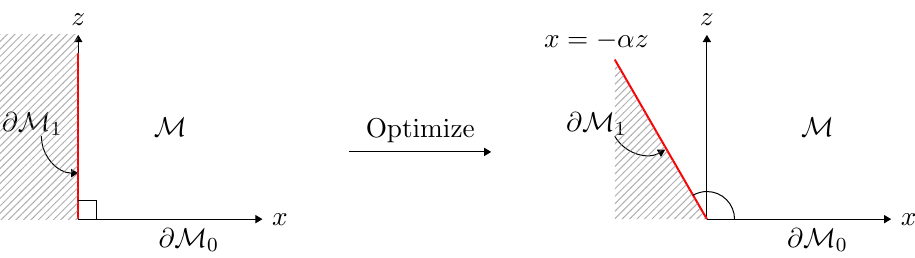
Figure 1 . (Left) The setup of the path integral for vacuum wave functional in BCFT. The boundary @ M 1 is located at x = 0 and the state is realized at @ M 0 = f x > 0 ; z = (cid:15) (cid:24) 0 g . (Right) The setup after the path-integral optimization. The boundary @ M 1 is